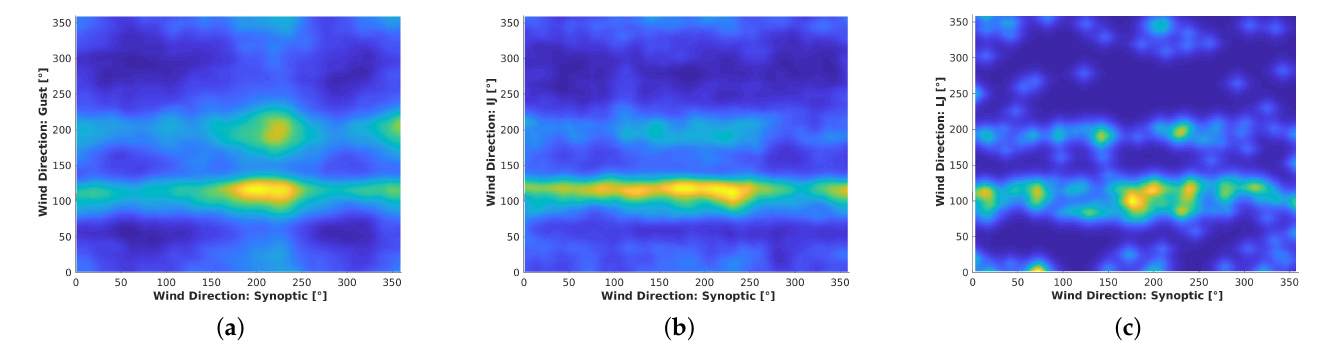
Figure 16. Correlation between the wind direction of a jet or gust and the highest measured wind direction above it. The relative frequency increases from blue over green and orange to yellow in arbitrary units. ( a ) Gusts, ( b ) Intermediate Jets, ( c ) Long